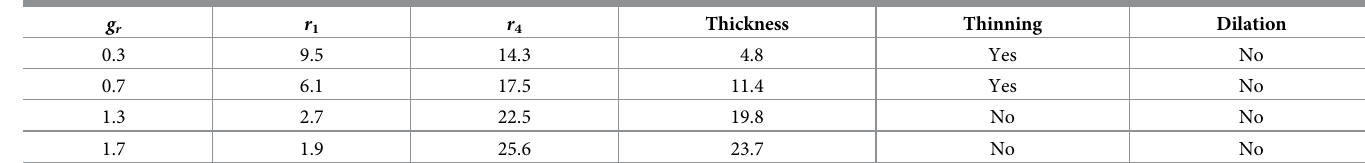
Table 2. Cervical wall thinning and dilation evaluation for different radial growth parameters g r under g θ = g z = 1. Length unit: mm. g r